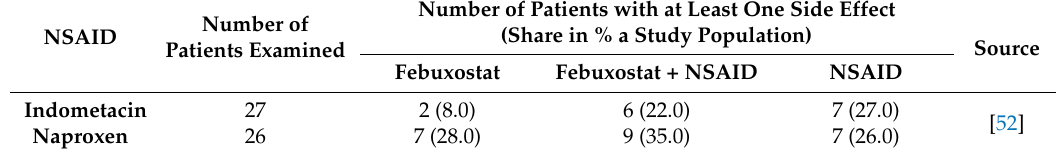
Table 2. Side effects during therapy with febuxostat and NSAID (applied NSAID (column 1); number of patients who were administered the NSAID (column 2); patients with at least one side effect during therapy with febuxostat (column 3), febuxostat together with NSAID (column 4); NSAID (column 5); publications reviewed (column